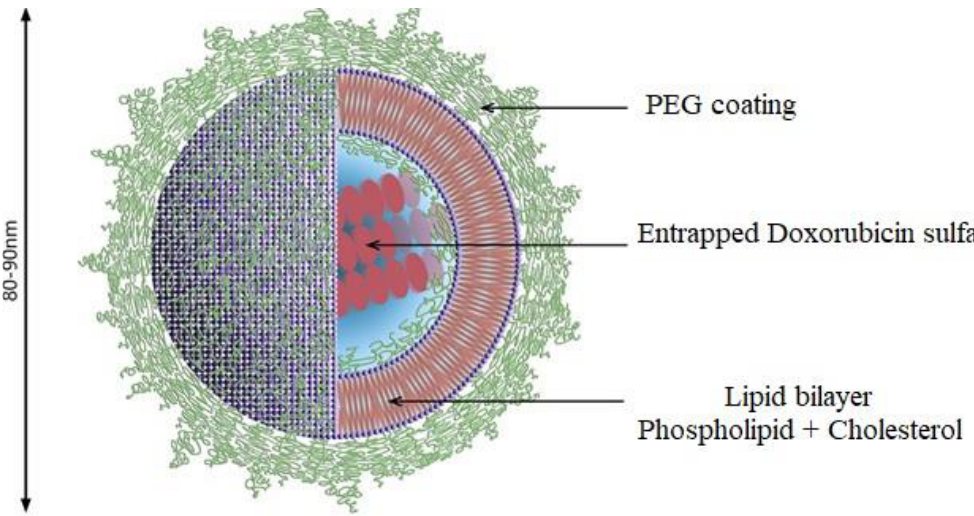
Figure 5. The structure of a typical PEGylated liposome along with its various layers and coatings. Adapted with permission from [99]; Published by BMJ Publishing Group Ltd., 2021.